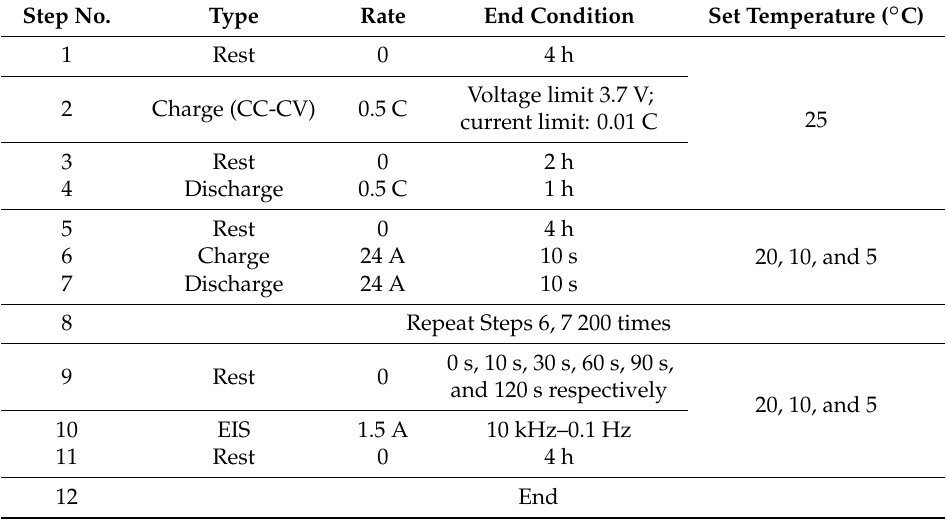
Table 5. The battery impedance test procedures C1 after different relaxation time.